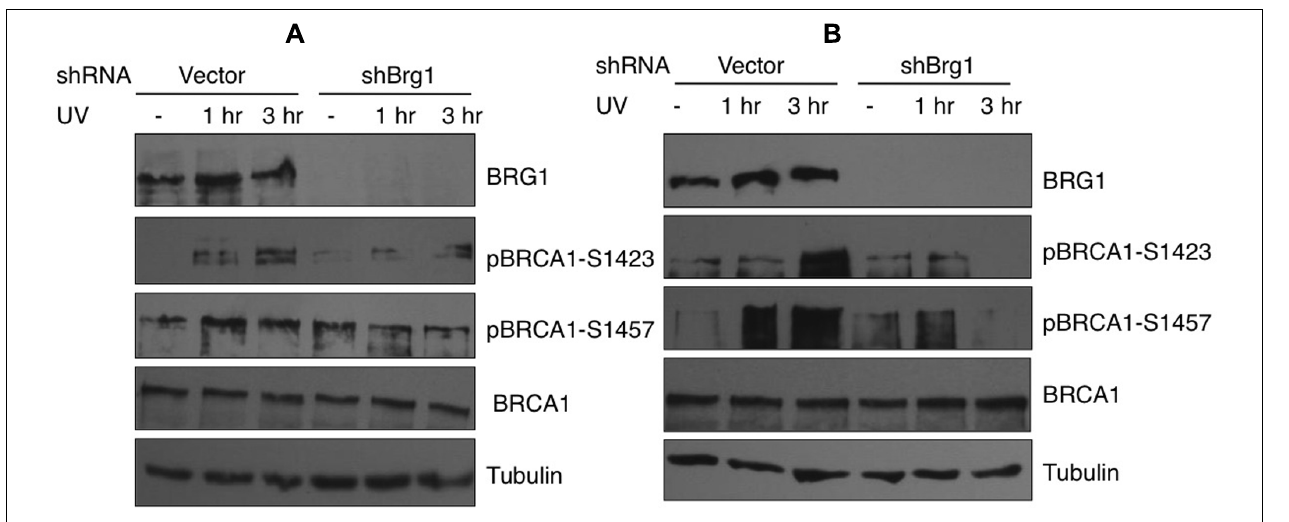
(Ser1457), anti-BRCA1, anti-humanBRG1, and anti-Tubulin antibodies. (B) BRG1-depleted HeLa cells and control cells were exposed to 30 J/m 2 and harvested 1 and 3 h after treatment. Cell lysates were immunoblotted using anti-phospho-BRCA1 (Ser1423), anti-phospho-BRCA1 (Ser1457), anti-BRCA1, anti-hBRG1, and anti-Tubulin antibodies.